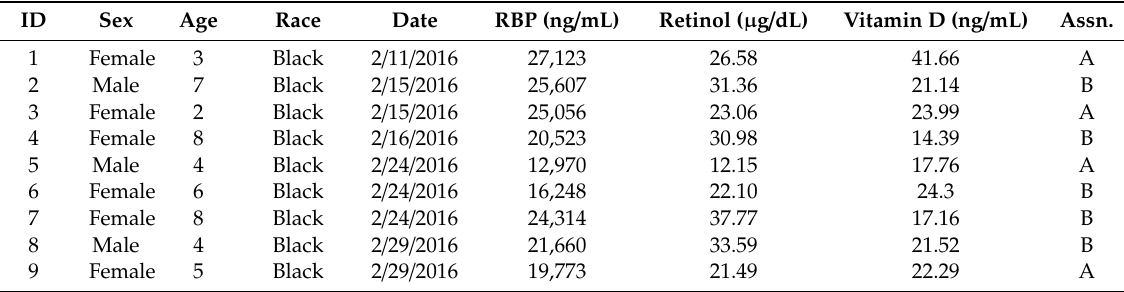
Table A1. Patient Characteristics